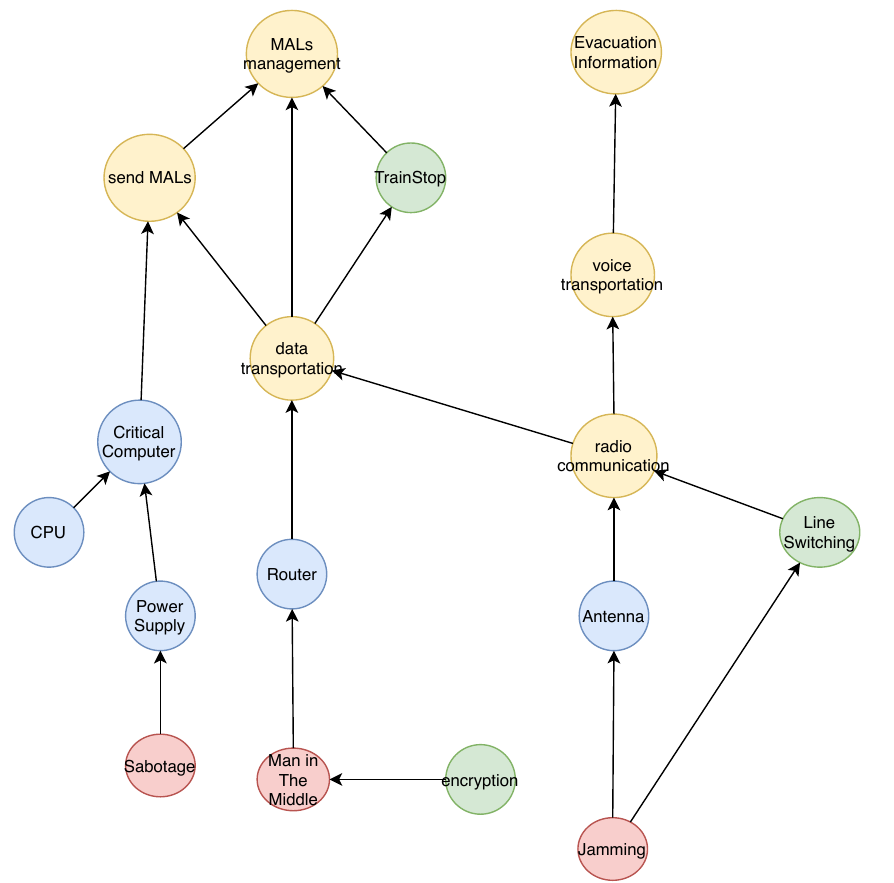
Figure 15. The BN model of the CTBC radio